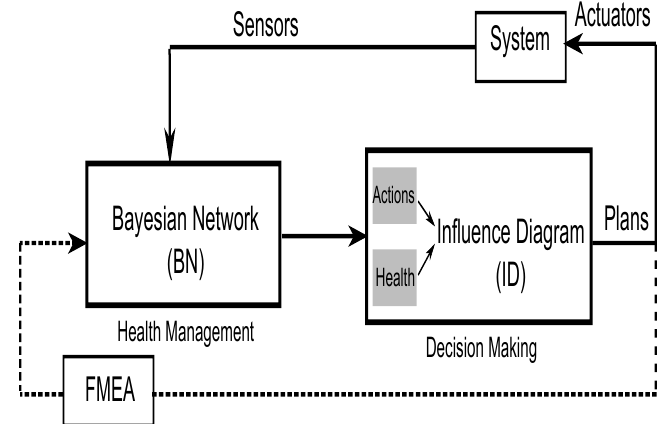
Figure 15. Embedded Decision Network for an autonomous